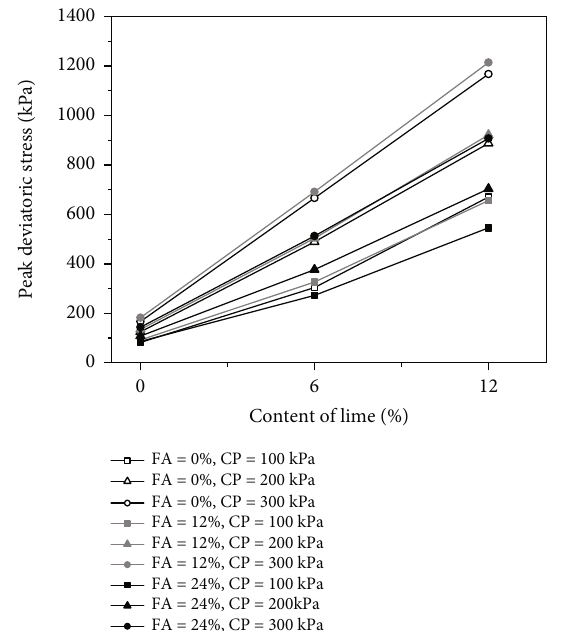
Figure 24: Peak deviatoric stress at di ff erent lime contents ( FT = 30 ).